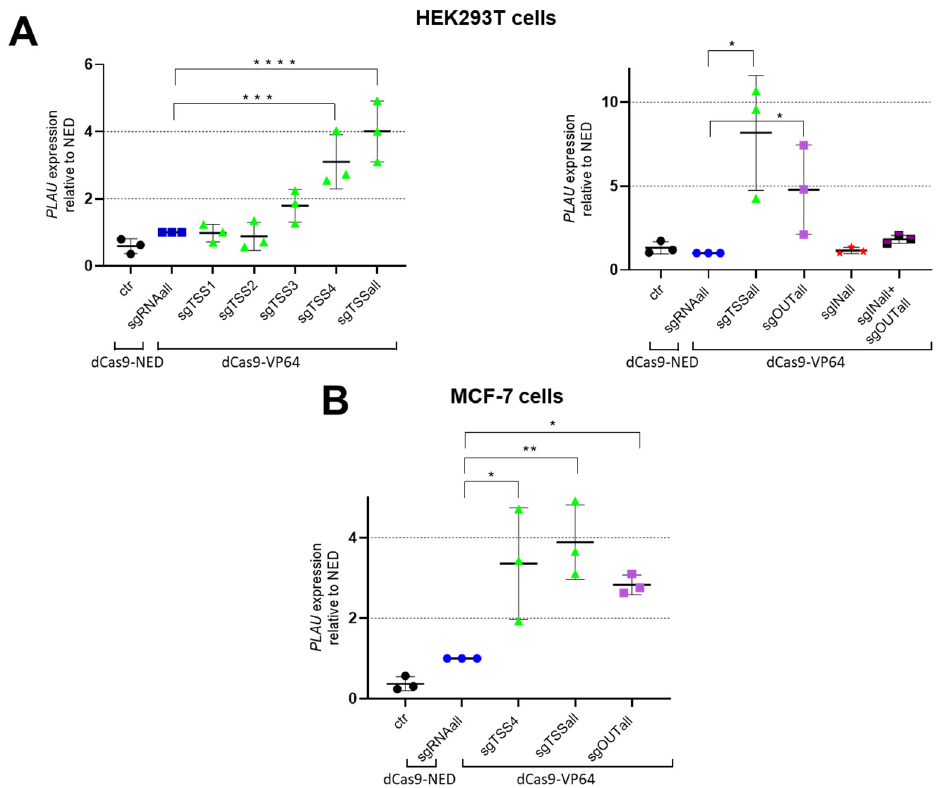
Figure 2. sgRNA-induced upregulation of PLAU expression in ( A ) HEK293T, and in ( B ) MCF-7 cells. ( A ) qRT-PCR results of HEK293T cells tested for VP64-induced upregulation using sgTSS4, individually and as mix, sgOUTall and/or sgINall; ( B ) qRT-PCR results of MCF-7 cells tested for VP64-induced upregulation using sgTSS4, sgTSSall and sgOUTall. Data are represented as means of 3 independent experiments, relative to GAPDH and normalised to transfected to cells with dCas9- NED. Significance is presented as compared to the dCas9-NED condition; * p < 0.05, ** p < 0.01, *** p < 0.005, **** p <